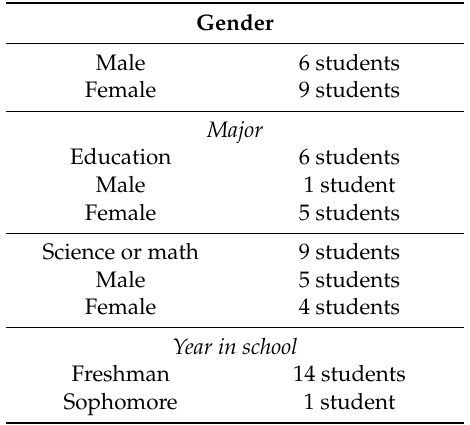
Table 1. Self-Reported Demographics of Study